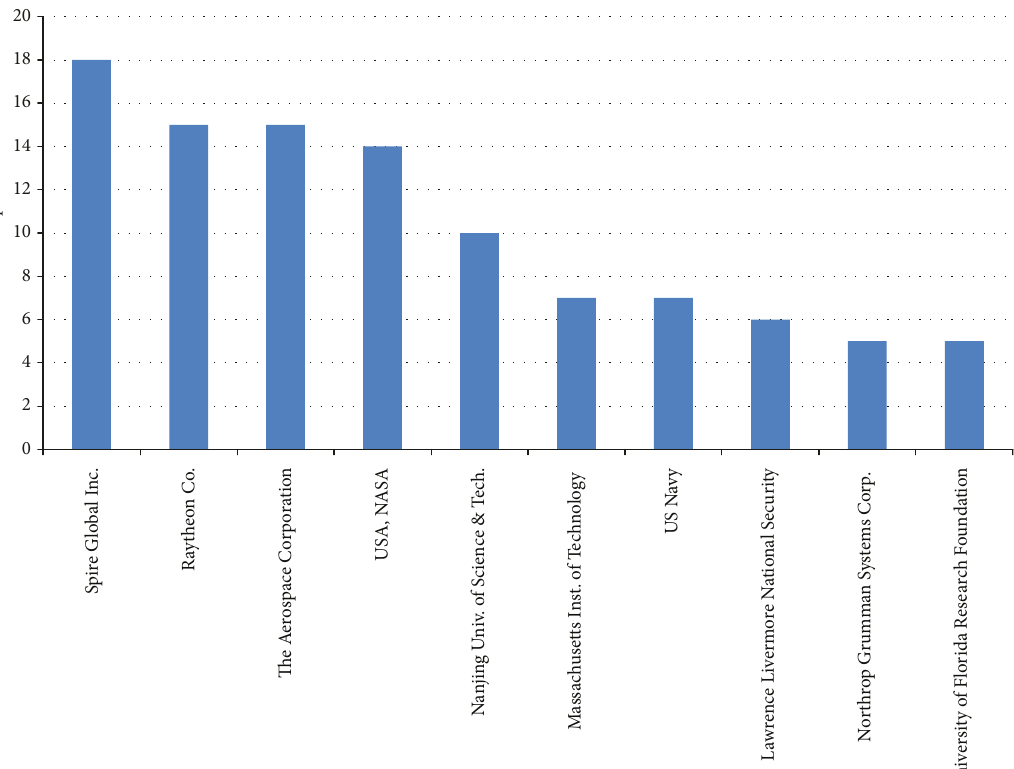
Figure 15: Main CubeSat patent holders, until December 2017 (source: